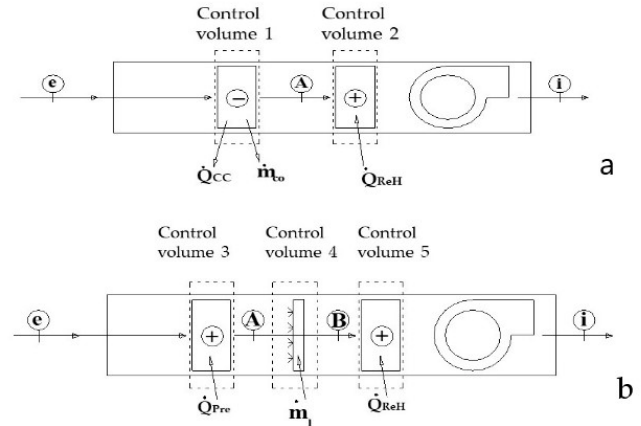
Figure 3. Scheme of the air handling unit for primary air and its components active in ( a ) summer and in ( b ) winter.